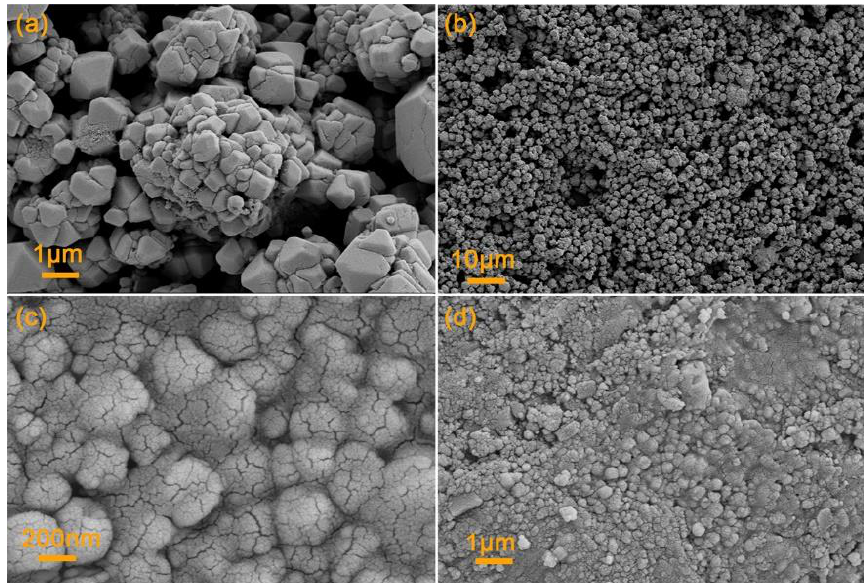
Figure 5. SEM images of ( a , b ) BiVO 4 and ( c , d ) Ag/BiVO 4 functionalized ceramic tiles obtained at 650 °C.